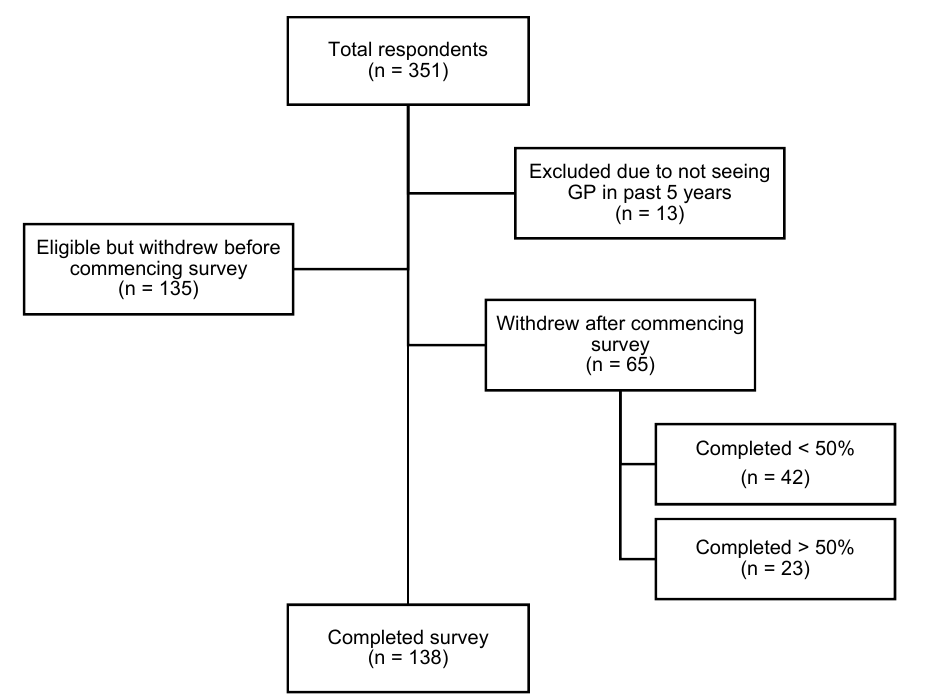
Figure 1. Flowchart demonstrating survey response rate.